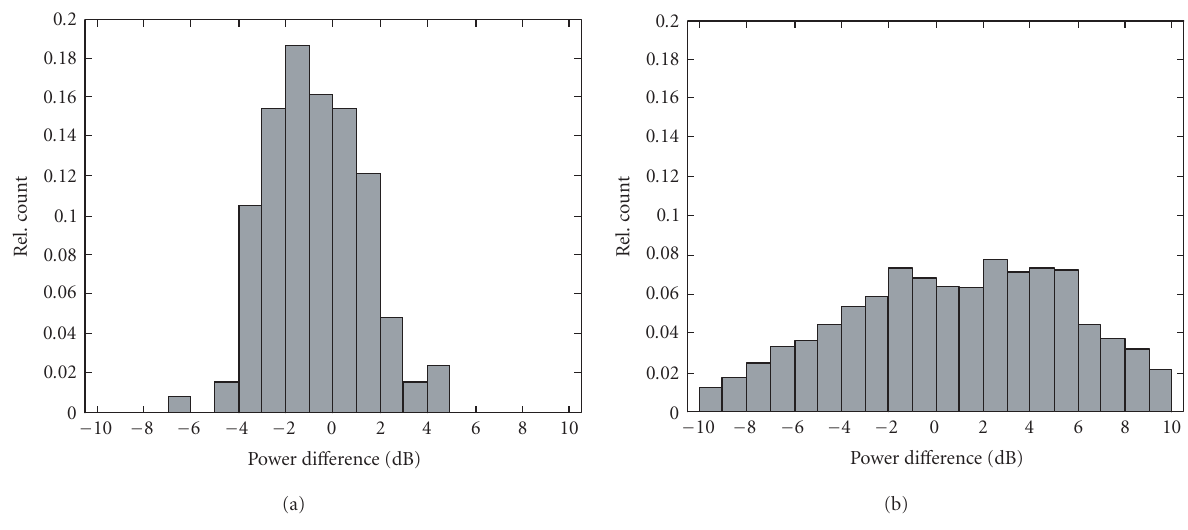
Figure 8: Histograms of mean branch power di ff erences for all measurements in the old building for (a) indoor and (b) outdoor-to-indoor with test persons excluding use position “at the